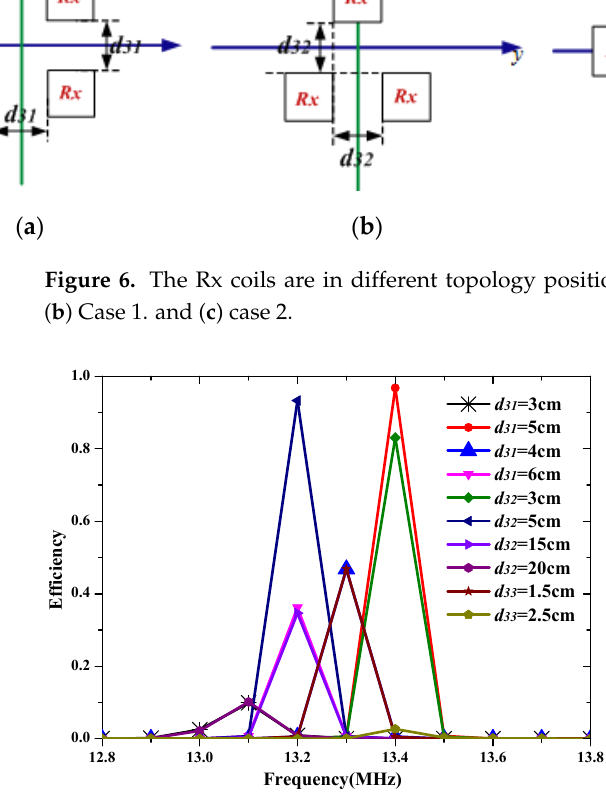
Figure 7. The efficiency of the STTR WPT system in a different spacing distance of the adjacent Rx coils.